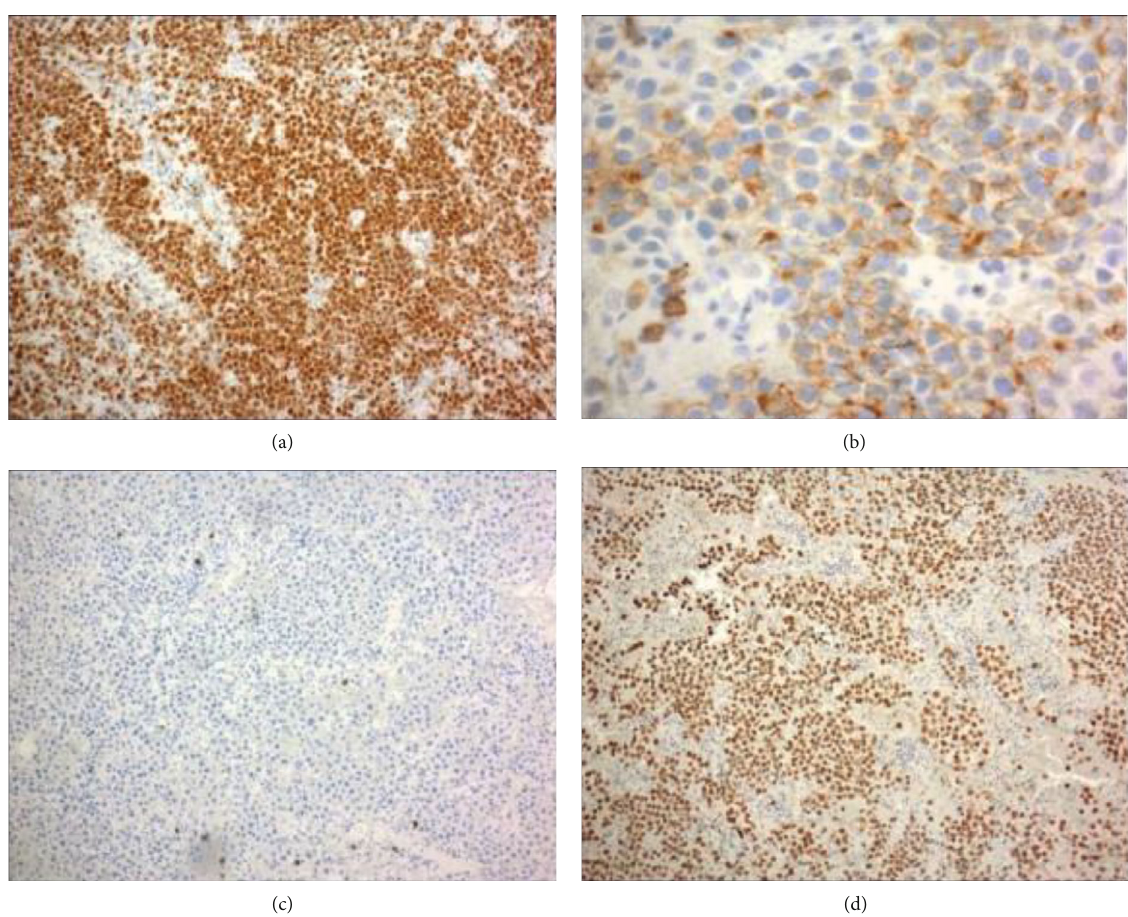
Figure 2: The large tumor cells are positive for MUM1 ((a) immunoperoxidase stain, 40x), partial positive for CD138 ((b) immunoperoxidase stain, 200x), and negative for CD20 ((c) immunoperoxidase stain, 40x) with Epstein – Barr virus-encoded RNA (EBER) transcripts identi fi ed by in situ hybridization ((d),